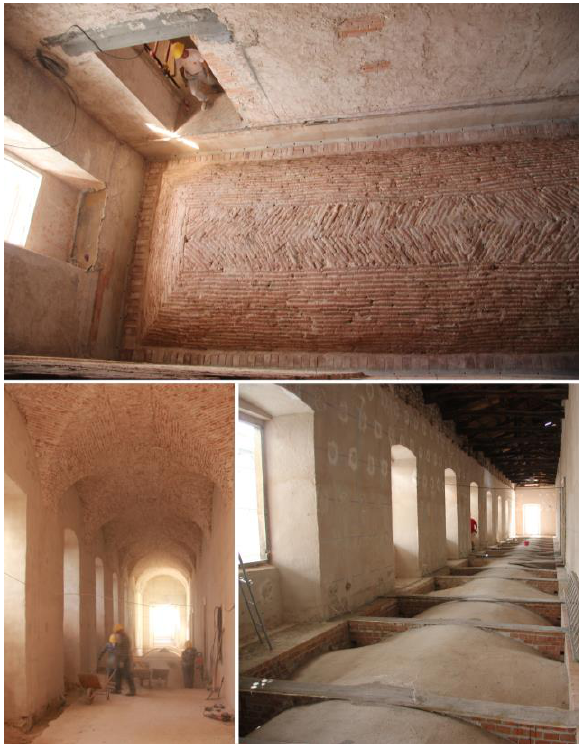
Figure 4. Photo of the restoration of Camponeschi palace realized after the 2009 earthquake: consolidation of the brick vaults with glass